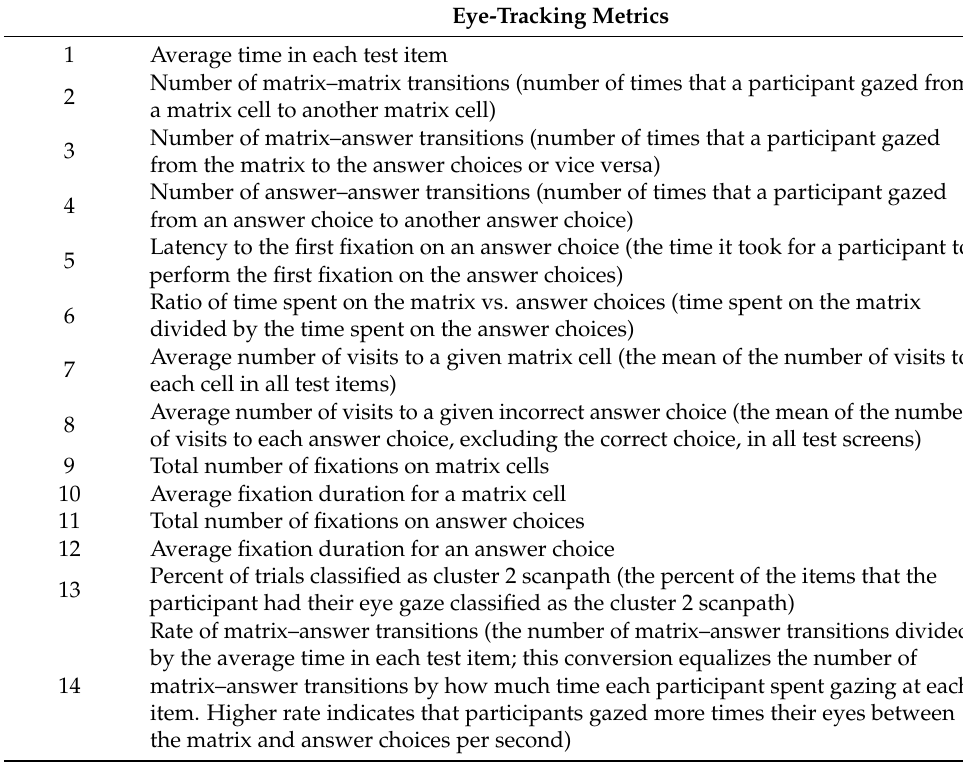
Table 1. Eye gaze metrics used in this